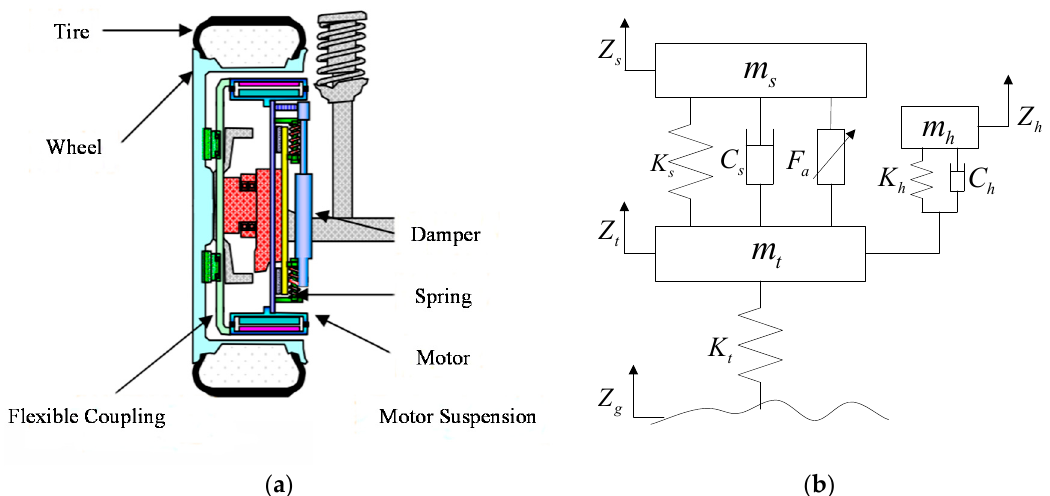
Figure 1. ( a ) Application model of an electric vehicle (EV) active suspension. ( b ) Quarter-car active suspension model.